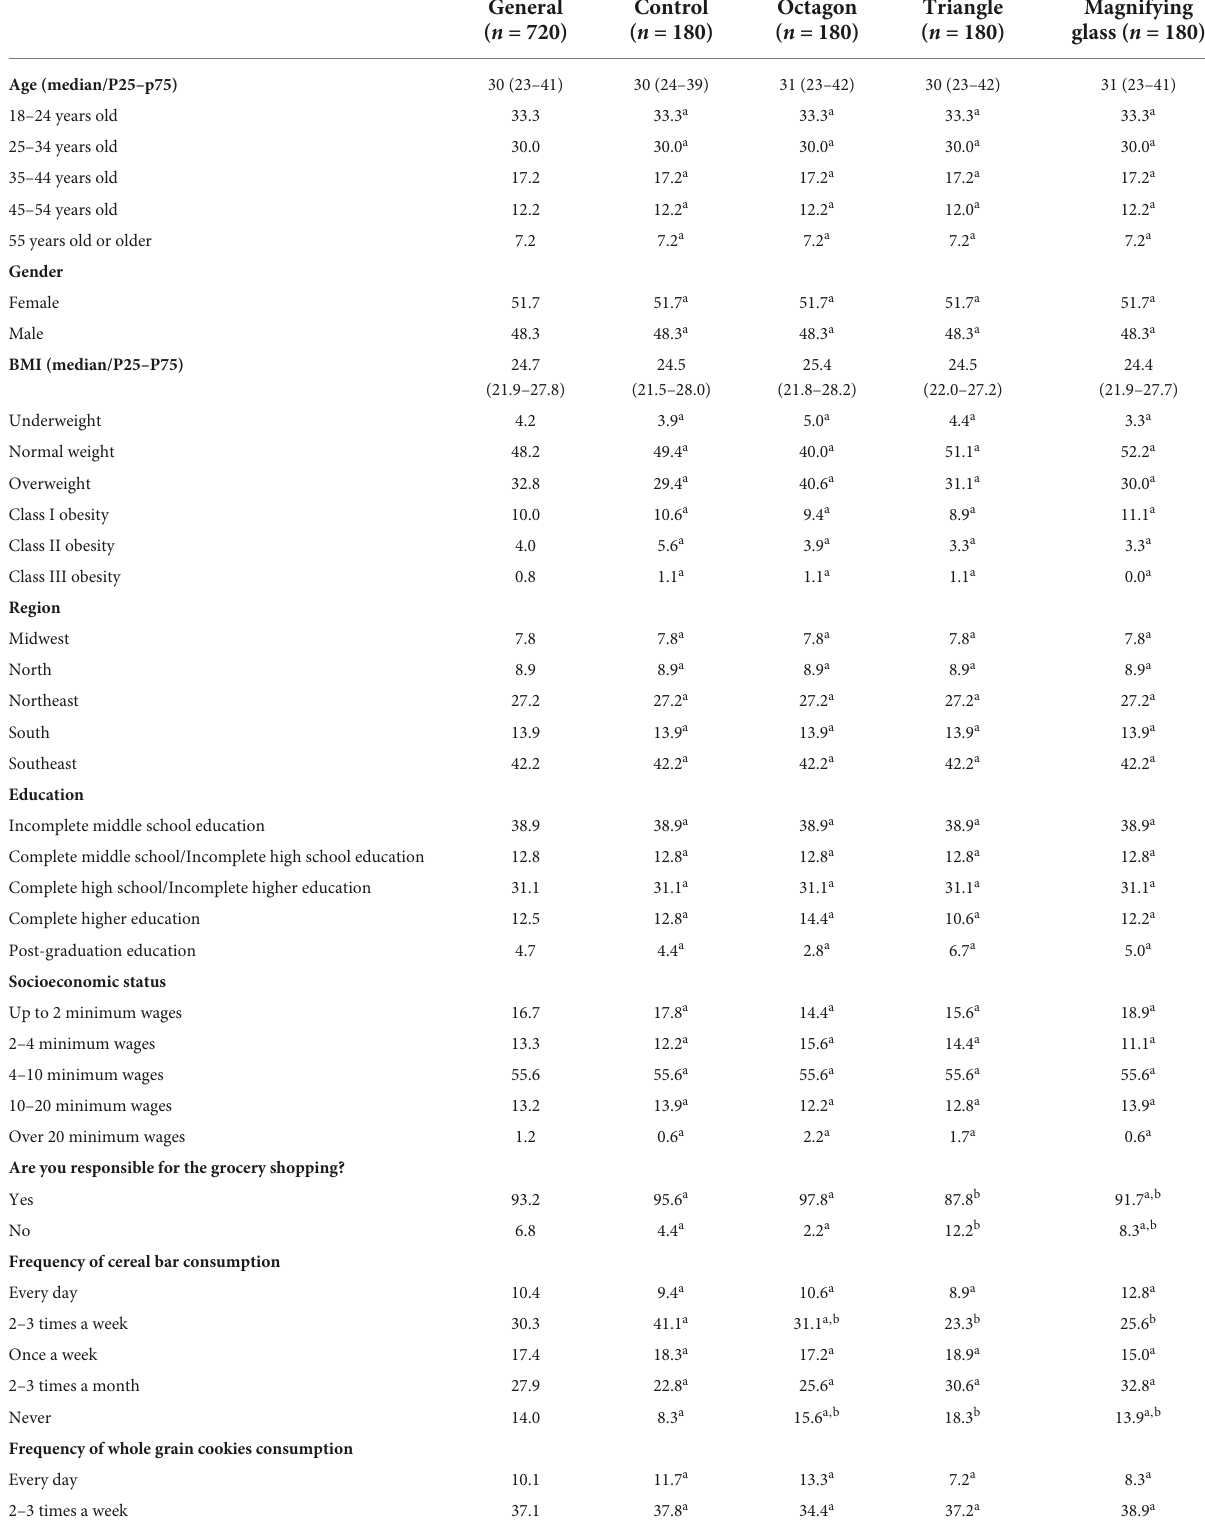
TABLE 2 Sociodemographic characteristics of the study